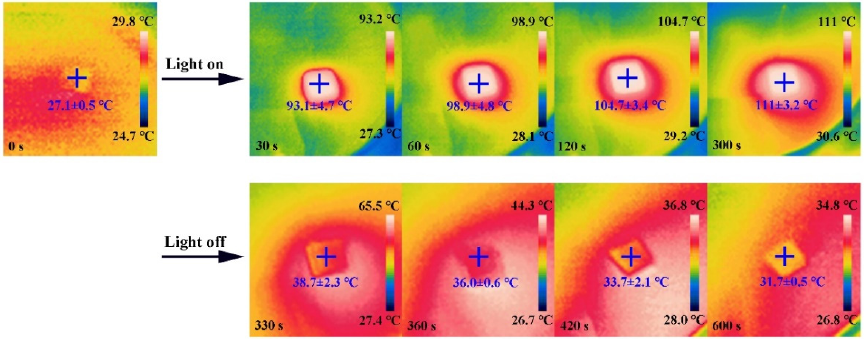
Figure 6. Infrared thermal pictures of Se@MS-2 under illumination at 1.0 W cm − 2 for one temperature on/off cycle. Table 1. Photothermal performance comparison of the recently reported materials.